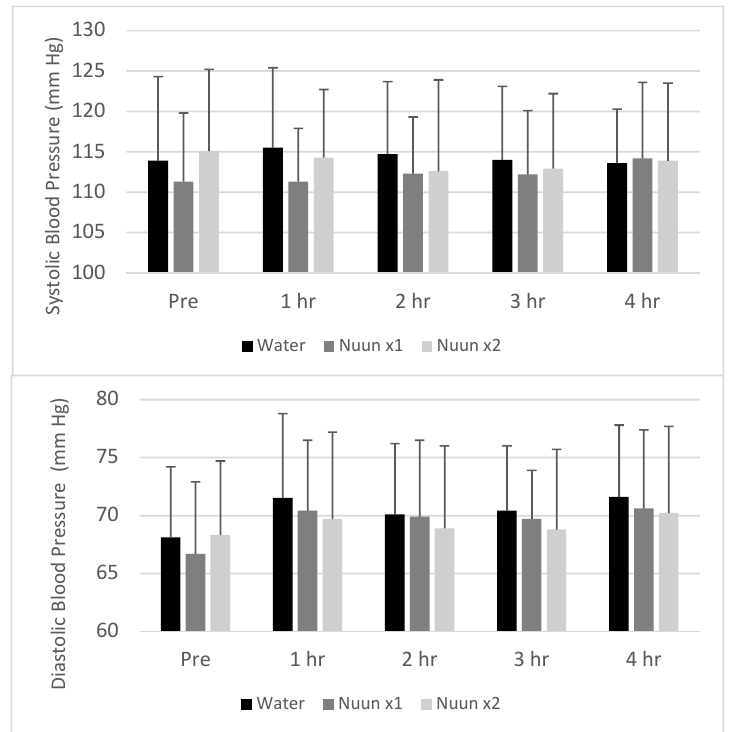
Figure 2. Systolic and diastolic blood pressure response of 18 men and women to water only and Nuun + water; Values are mean ± standard deviation; mm Hg is mm Mercury, hr is hour(s) after condition ingestion, Nuun x1 is Nuun beverage at normal concentration, Nuun x2 is Nuun beverage at double concentration; No di ff erences of statistical significance were noted ( p >